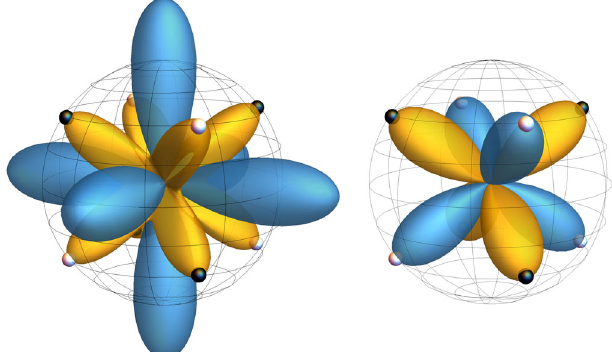
FIG. 5. Linear-rotor codes. Sketch of two polyhedral harmonics for the T code on S 2 , whose two code words are equal super- positions of the white and black points, respectively. The left harmonic is the code ’ s check operator the logical- Z operator (117). Positive (negative) values are in yellow (blue), and the outlined spheres have radius